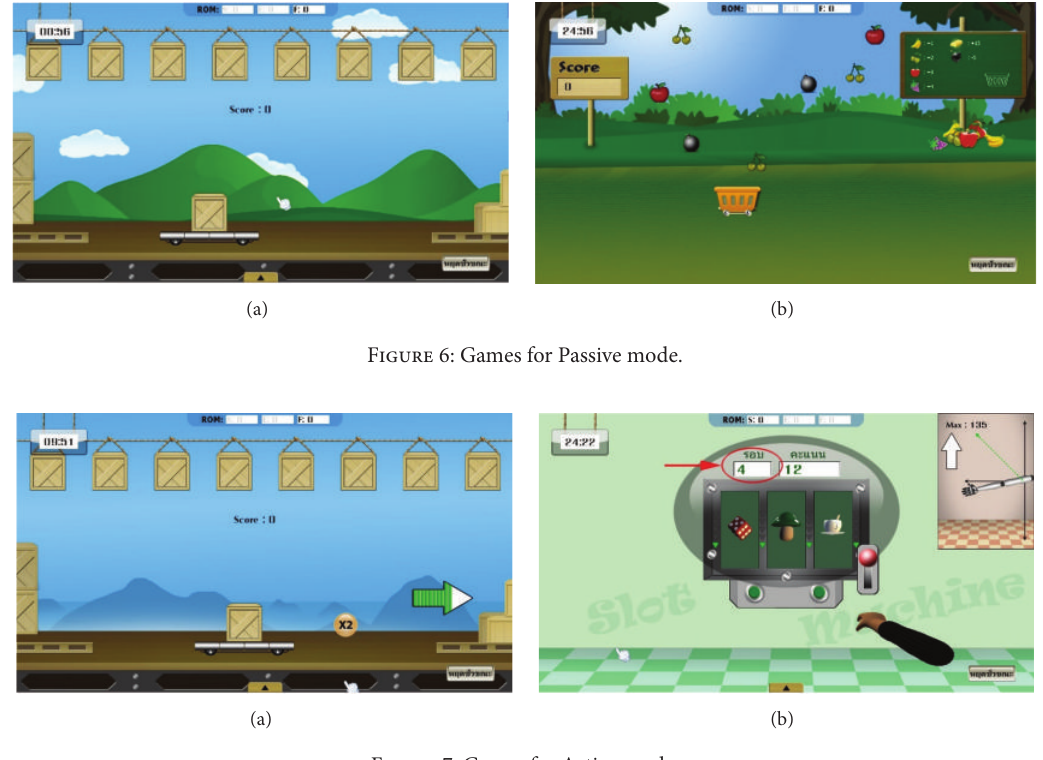
Figure 7: Games for Active